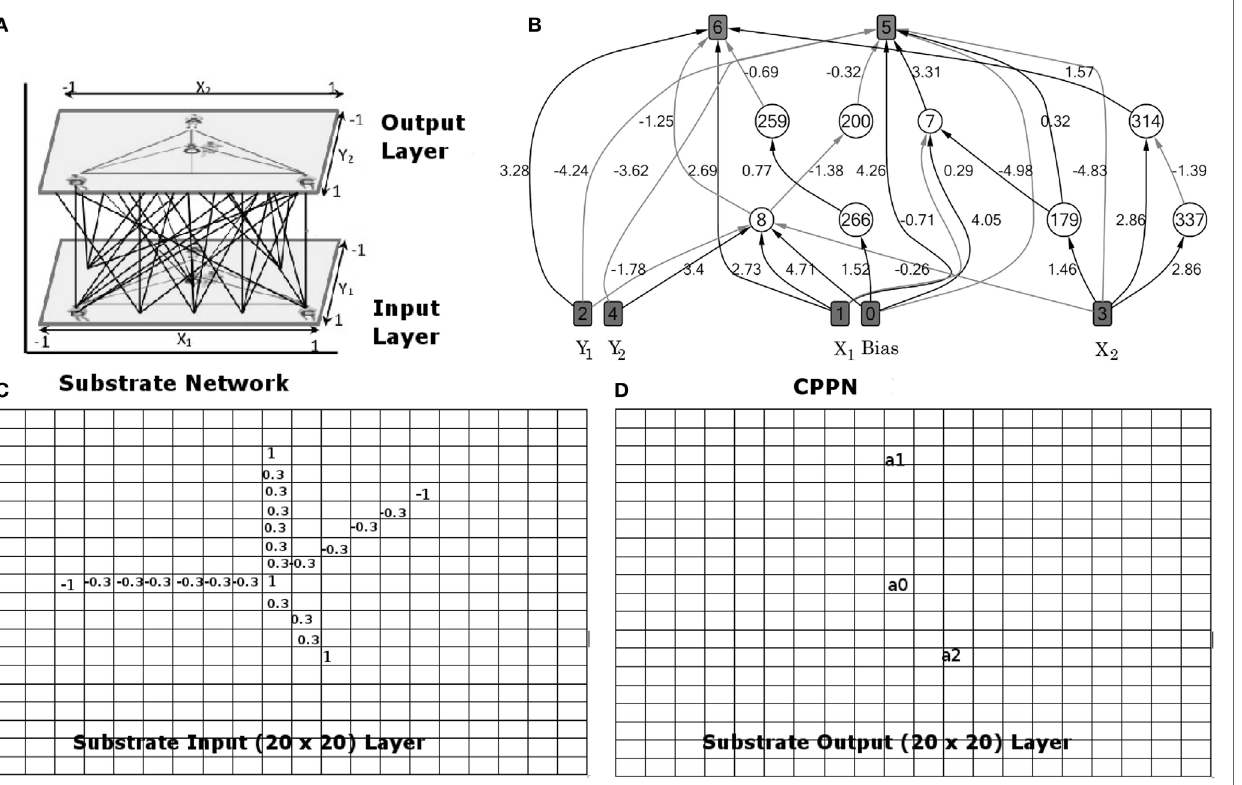
FigUre 1 | (a) Substrate network encoding virtual field (20 × 20 grid of inputs and outputs). (B) Connections from pairs of nodes in the substrate are sampled and the coordinates passed as inputs to the CPPN, which then outputs the synaptic weight (connecting input and output layers in the substrate). (c) Substrate input layer (20 × 20) corresponding to bottom layer in sub-figure (a). (D) Substrate output layer (20 × 20) corresponding to top layer in sub-figure (a). Note: this figure assumes 3vs2 keep-away, though any keep-away task is applicable. See text (Section 3.2.1) for